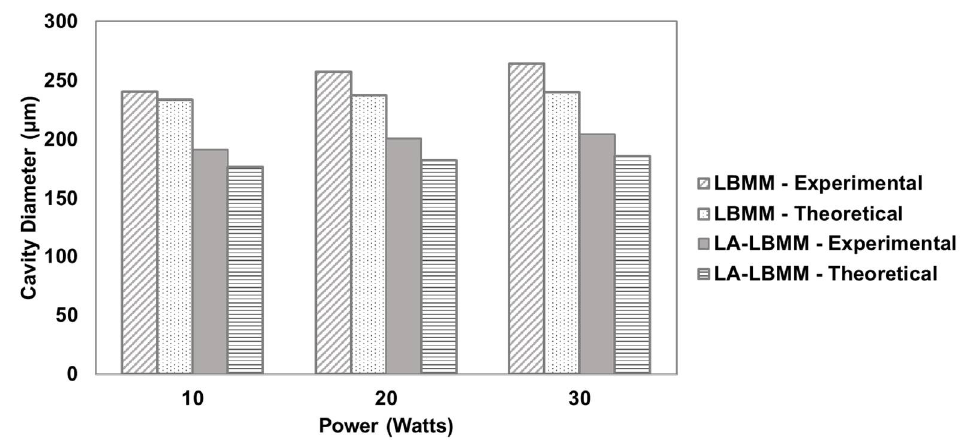
Figure 11. Comparison between cavity diameters of experimental and theoretical model predictions for LBMM and LA-LBMM processes.